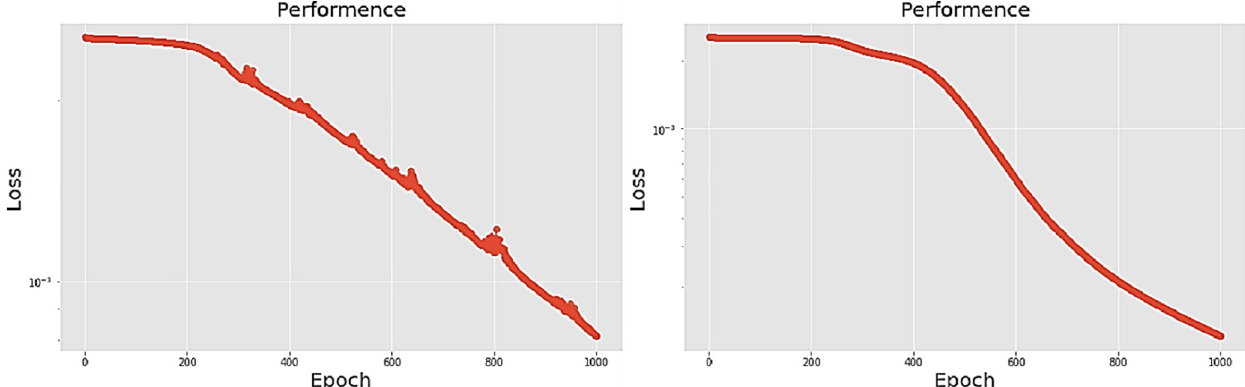
Fig 21. (a) The graph shows the performance of LPC-LSTM-2 × 200 model; (b) The graph shows the performance of LPC-PCA-LSTM-2 × 200